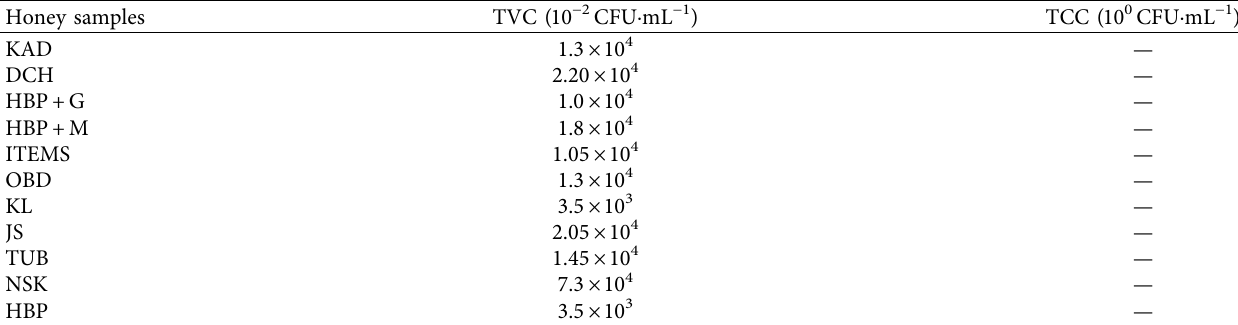
Table 2: Microbial count of honey samples.